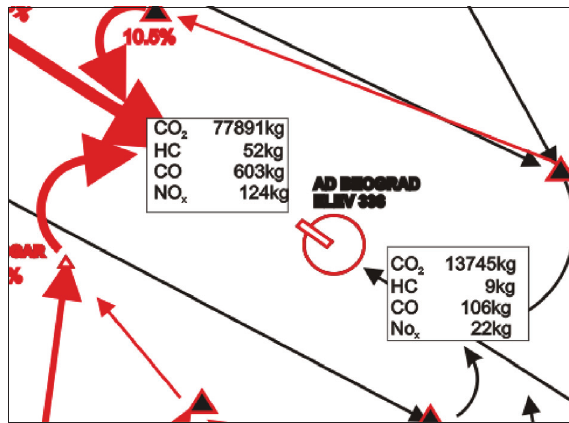
Fig. 5. The arrival routes at RWY 12 (red line) and RWY 30 (black line) with percentage of arrival route use